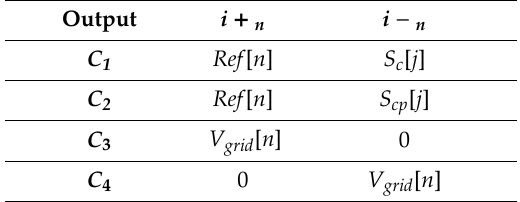
Table 2. Input and output relationship of comparator array.